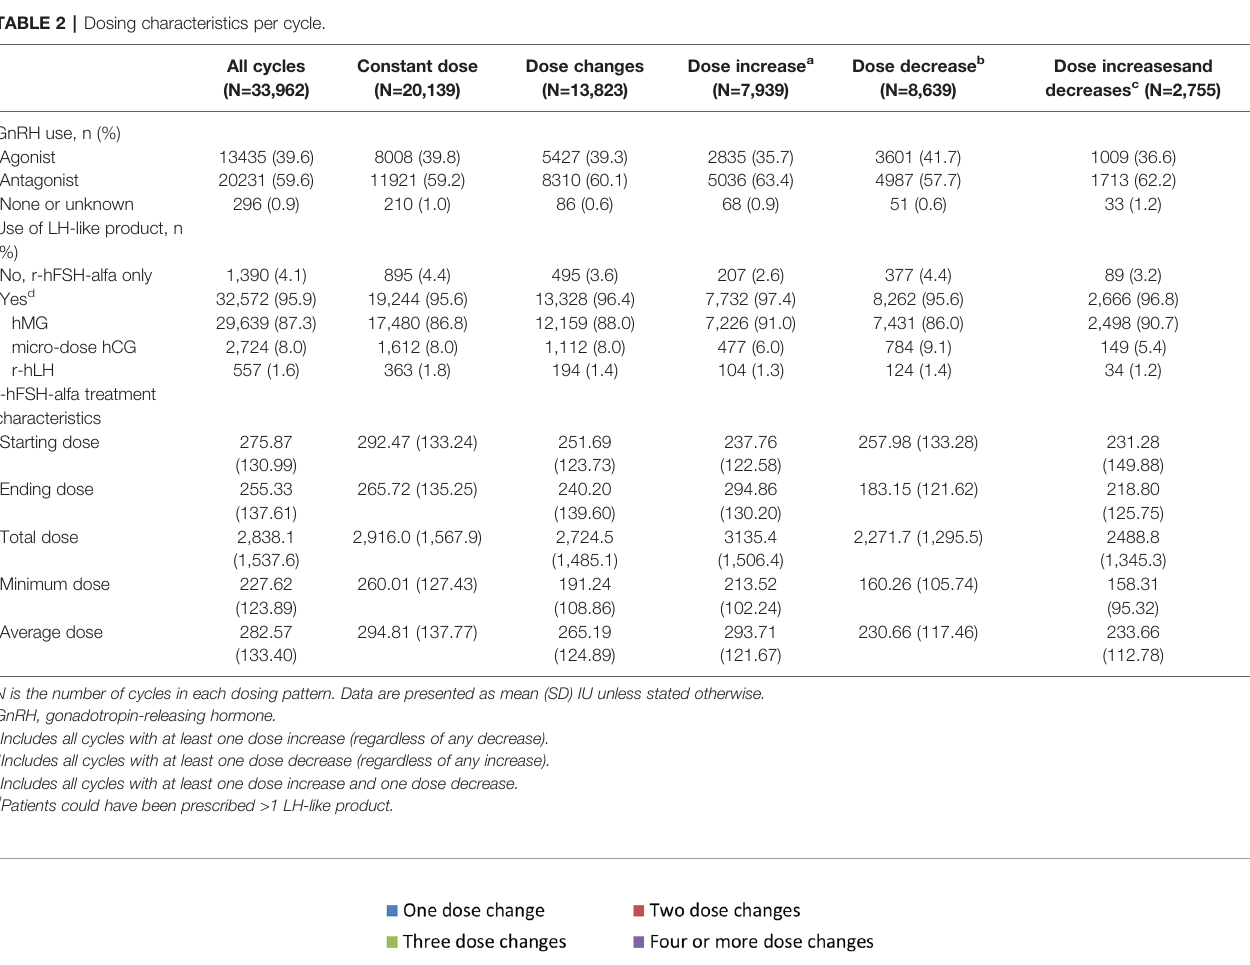
Dose increasesand decreases c (N=2,755)